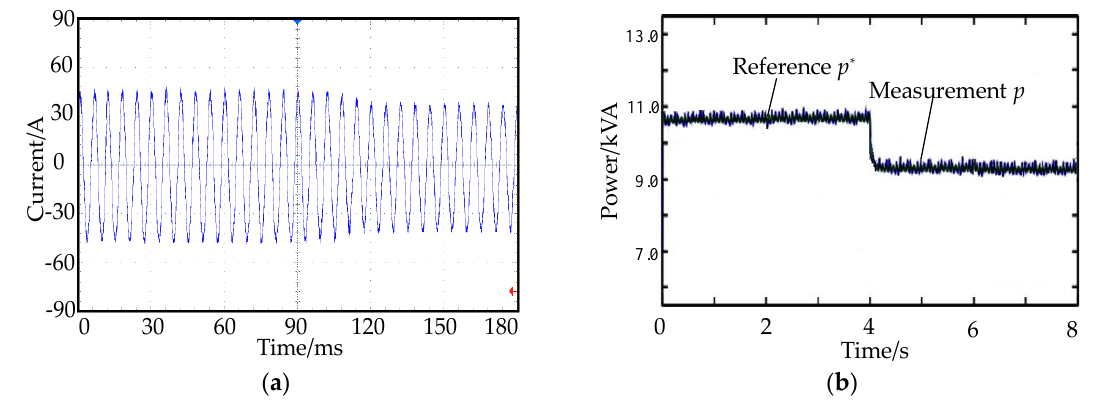
Figure 17. Dynamic response at load change. ( a ) generator output current; ( b ) reference and measurement power.